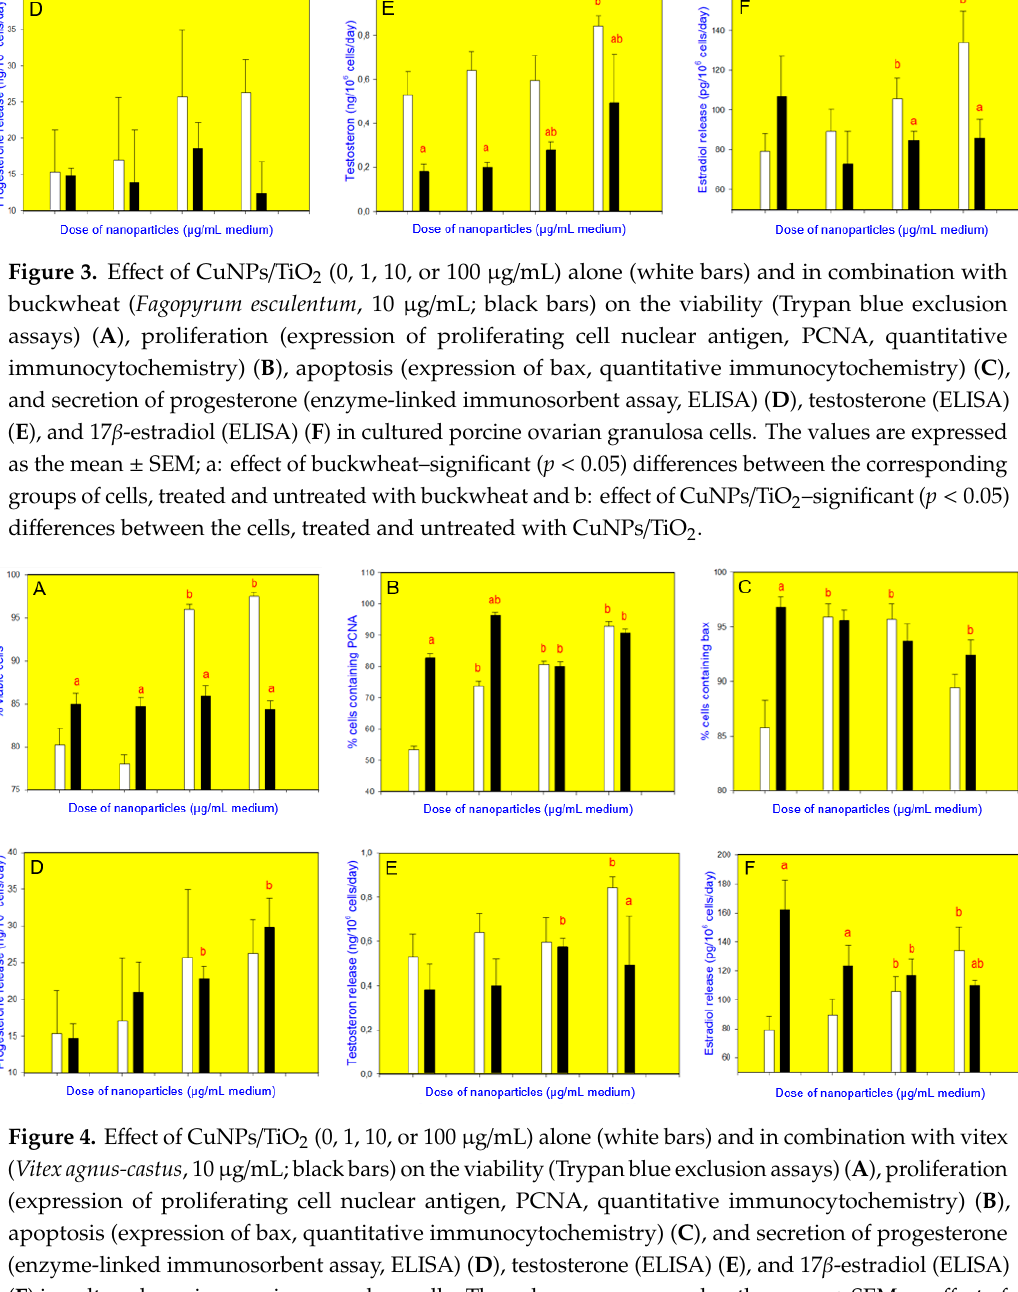
Figure 4. E ff ect of CuNPs / TiO 2 (0, 1, 10, or 100 µ g / mL) alone (white bars) and in combination with vitex ( Vitex agnus-castus , 10 µ g / mL; black bars) on the viability (Trypan blue exclusion assays) ( A ), proliferation (expression of proliferating cell nuclear antigen, PCNA, quantitative immunocytochemistry) ( B ), apoptosis (expression of bax, quantitative immunocytochemistry) ( C ), and secretion of progesterone (enzyme-linked immunosorbent assay, ELISA) ( D ), testosterone (ELISA) ( E ), and 17 β -estradiol (ELISA) ( F ) in cultured porcine ovarian granulosa cells. The values are expressed as the mean ± SEM; a: e ff ect of vitex–significant ( p < 0.05) di ff erences between the corresponding groups of cells, treated and untreated with vitex and b: e ff ect of CuNPs / TiO 2 –significant ( p < 0.05) di ff erences between the cells, treated and untreated with CuNPs / TiO 2